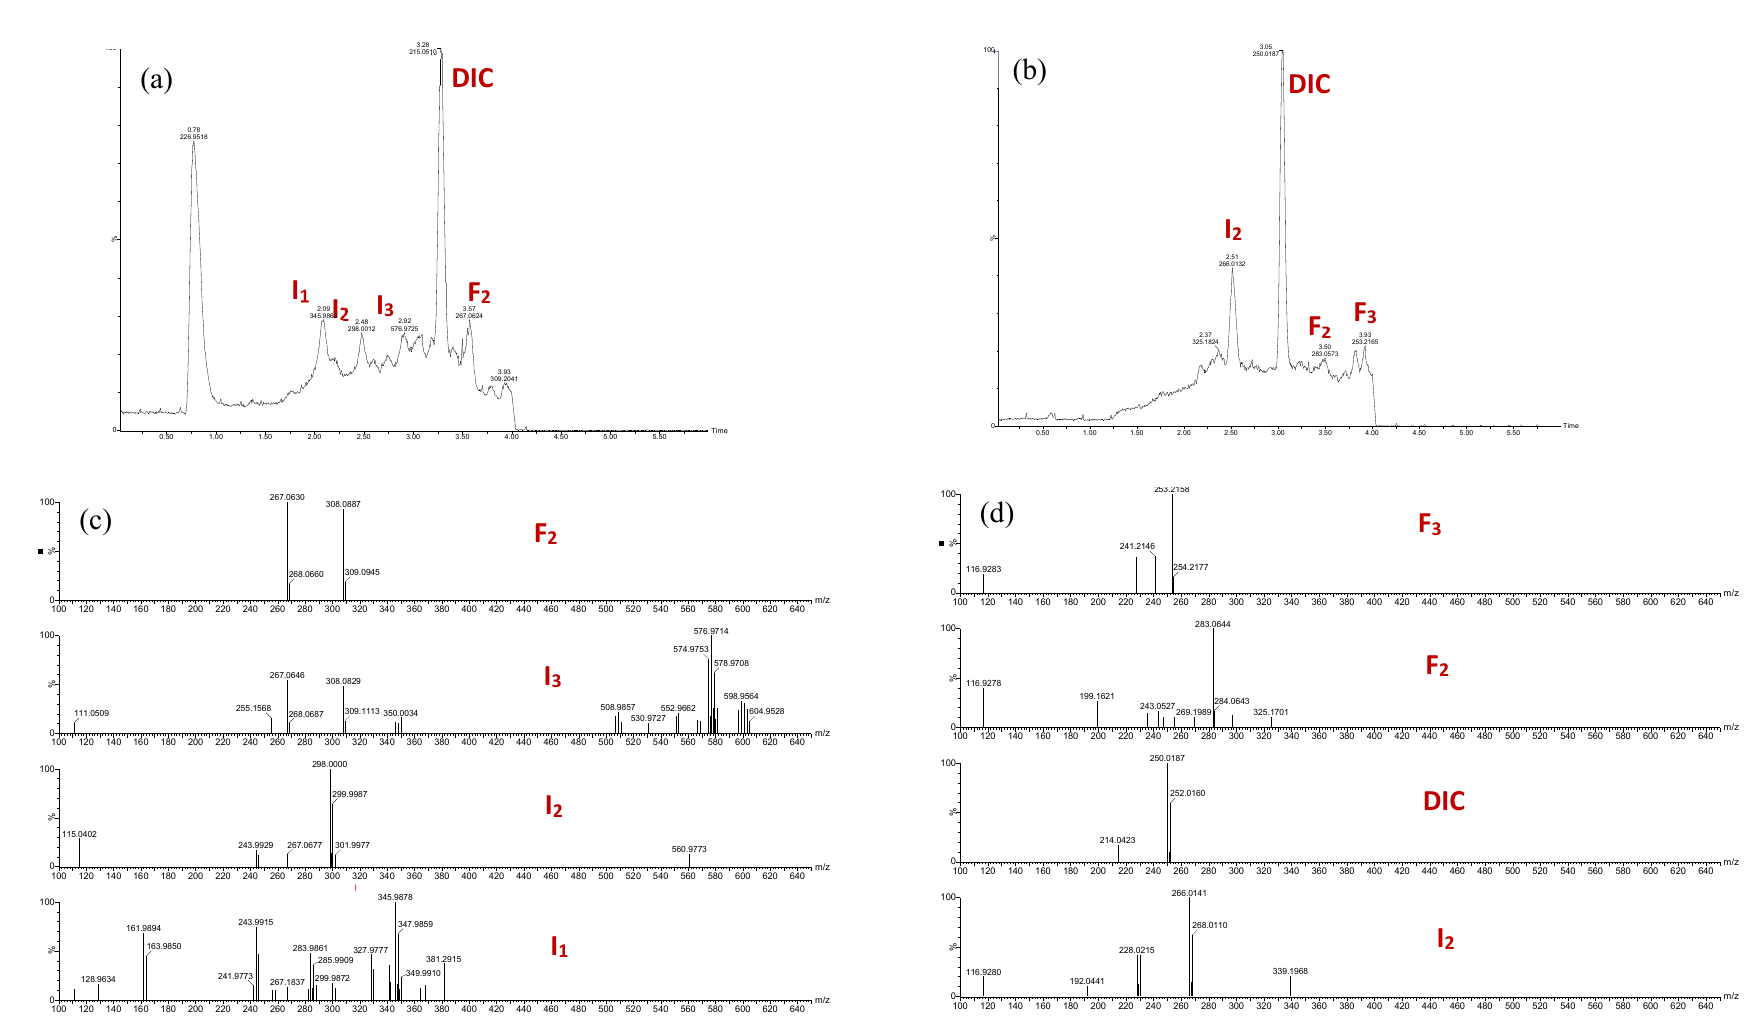
Figure 4. HPLC–MS chromatographic patterns of degradation intermediates. ( a ) TIC in the ESI+ mode, ( b ) TIC in the ESI− mode, ( c ) MS patterns in the ESI+ mode, and ( d ) MS pa(cid:308)erns in the ESI− mode under a pH of 5 for a reaction time of 2 h with an initial MnO 2 loading of 200 mg/L.